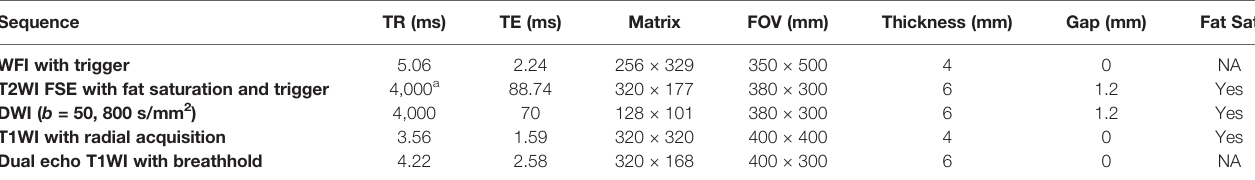
TABLE 1 | Acquisition parameters for the applied MR sequences. Sequence TR (ms) TE (ms) Matrix Fat Sat WFI with